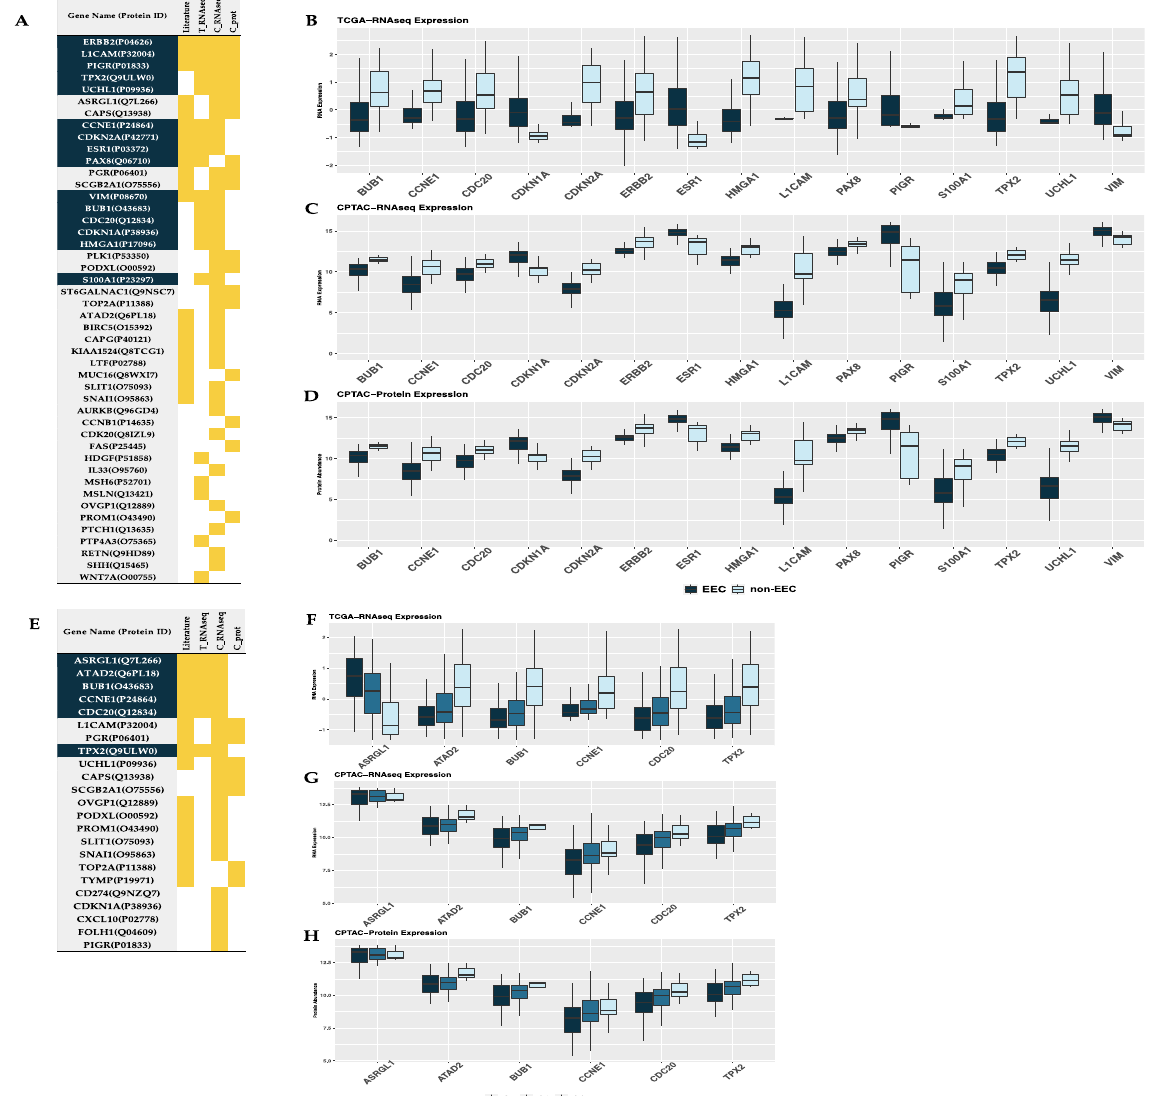
Figure 3. Biomarkers related to histological type and histological grade. ( A , E ) Table of the proteins that were found differentially expressed between: ( A ) endometrioid (EEC) and non-endometrioid (non-EEC), and ( E ) G1G2 and G3, respectively, in any of the tested cohorts. Highlighted in yellow, the specific cohort in which that protein was found to be differentially expressed between histologies and/or grades. Proteins highlighted in blue are those validated in more than one cohort, and therefore, the ones that we considered as validated biomarkers. ( B – D ) Boxplots showing the expression of the 15 validated biomarkers for histological type in each cohort of patients: TCGA RNA-Seq data, CPTAC RNA-Seq data, and CPTAC proteomic data, respectively. ( F – H ) Boxplots showing the expression of the six validated biomarkers for histological grade in each cohort of patients: TCGA RNA-Seq data, CPTAC RNA-Seq data, and CPTAC proteomic data, respectively. Literature: literature revision from Coll-de la Rubia E et al., 2020 [15]; T_RNAseq: RNA-Seq data of the TCGA’s cohort; C_RNAseq: RNA-Seq data of the CPTAC’s cohort; C_prot: proteomic data of the CPTAC’s cohort.